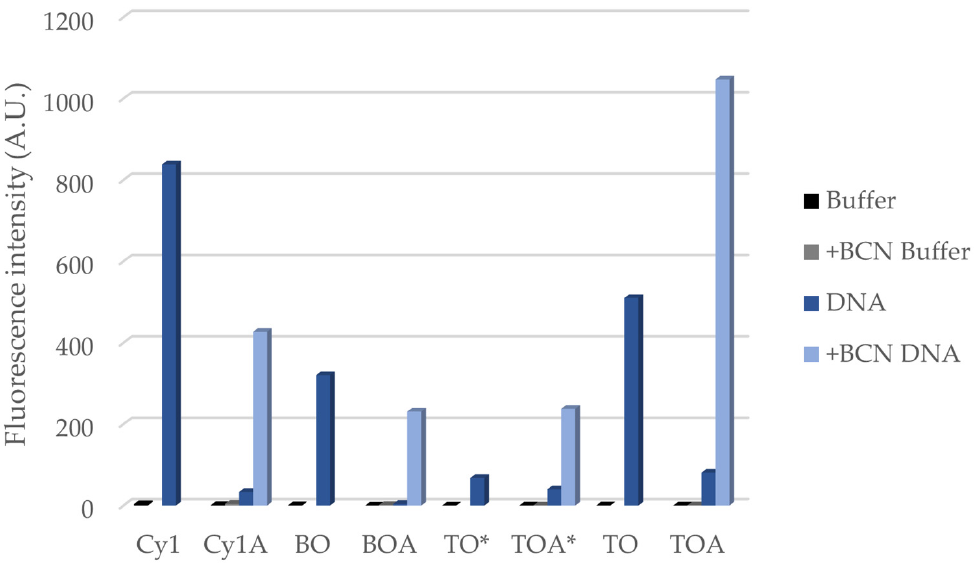
Figure 2. Fluorescence intensities of 1.0 µ M Cy1, BO , TO*, and TO frames, their azide modified derivatives, and the BCN conjugates of the azides in the absence and presence of 0.4 mg/mL calf thymus dsDNA in TRIS–PBS 1:4 at 21 °C. λ exc : 405 nm for Cy1, 420 nm for BO, 460 nm for TO*, and 480 nm for TO derivatives, the emission was recorded at the maxima.